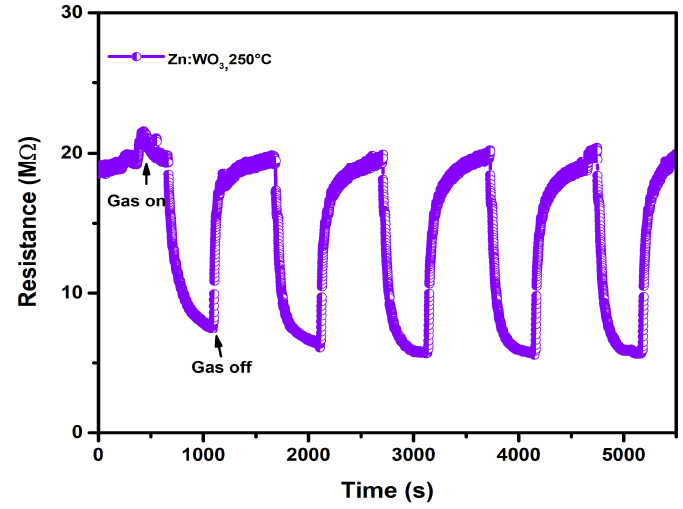
Figure 10. Repeatability measurements of Zn: WO 3 film. Table 3. Comparison study with the previously reported NH 3 sensors.